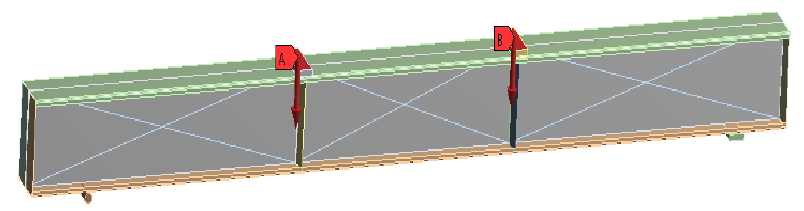
Figure 18. Loading applied on the FE model.